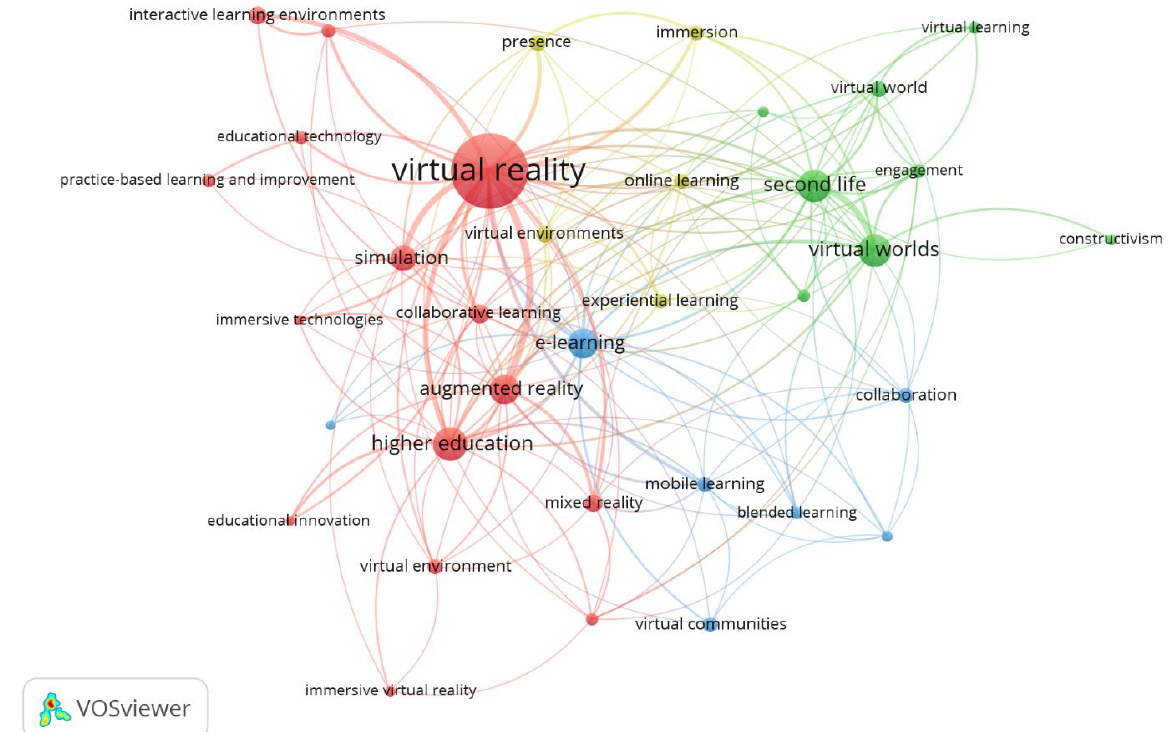
Figure 5. Figure 5 shows the cartography analysis through VOSviewer software. The purpose of the analysis is to identify the keywords under each research stream. The minimum selected scale of co-occurrence for a keyword is